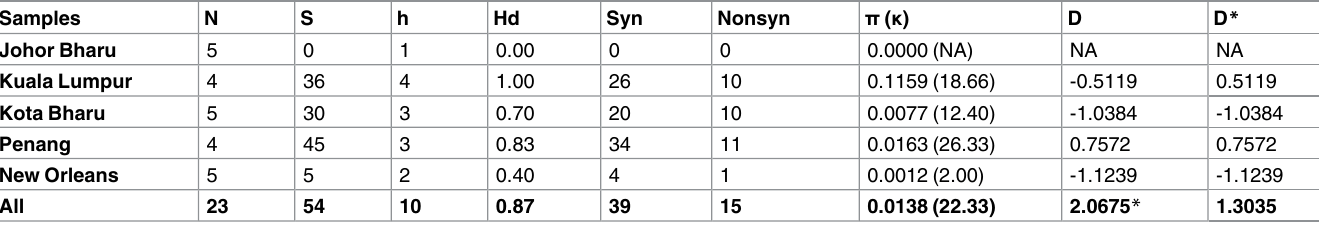
Table 2. Summarystatistics for polymorphism of CYP9J27 haplotypes from unexposed samples and susceptible NO strains, across Malaysia. Samples